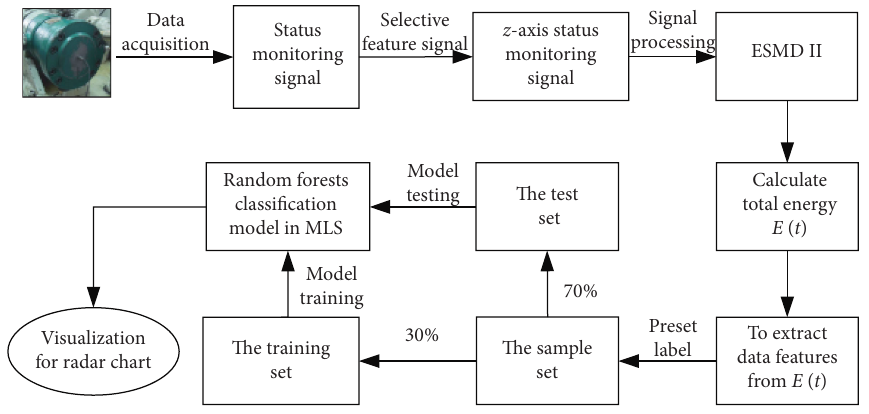
Figure 2: Flow chart of the proposed method.